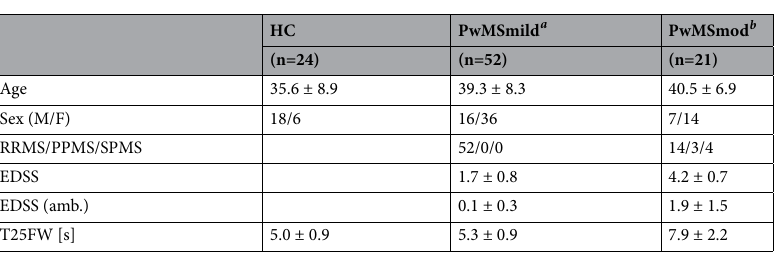
1 Table 1. Population Demographics of the FLOODLIGHT PoC dataset . Clinical scores taken as the average per subject over the entire study, where the mean ± standard deviation across population are reported; RRMS, Relapsing-remitting MS; PPMS, Primary-progressive MS; SPMS, Secondary-progressive MS; EDSS, Expanded Disability Status Scale; T25FW, the Timed 25-Foot Walk; EDSS (amb.) refers to the ambulation sub-score as 1 part of the EDSS; [s], indicates measurement in seconds; For more information on the study population we a b refer the reader to 3 and 37 ; PwMS with average EDSS < 3.5 ; PwMS with average EDSS ≥ 3.5 .